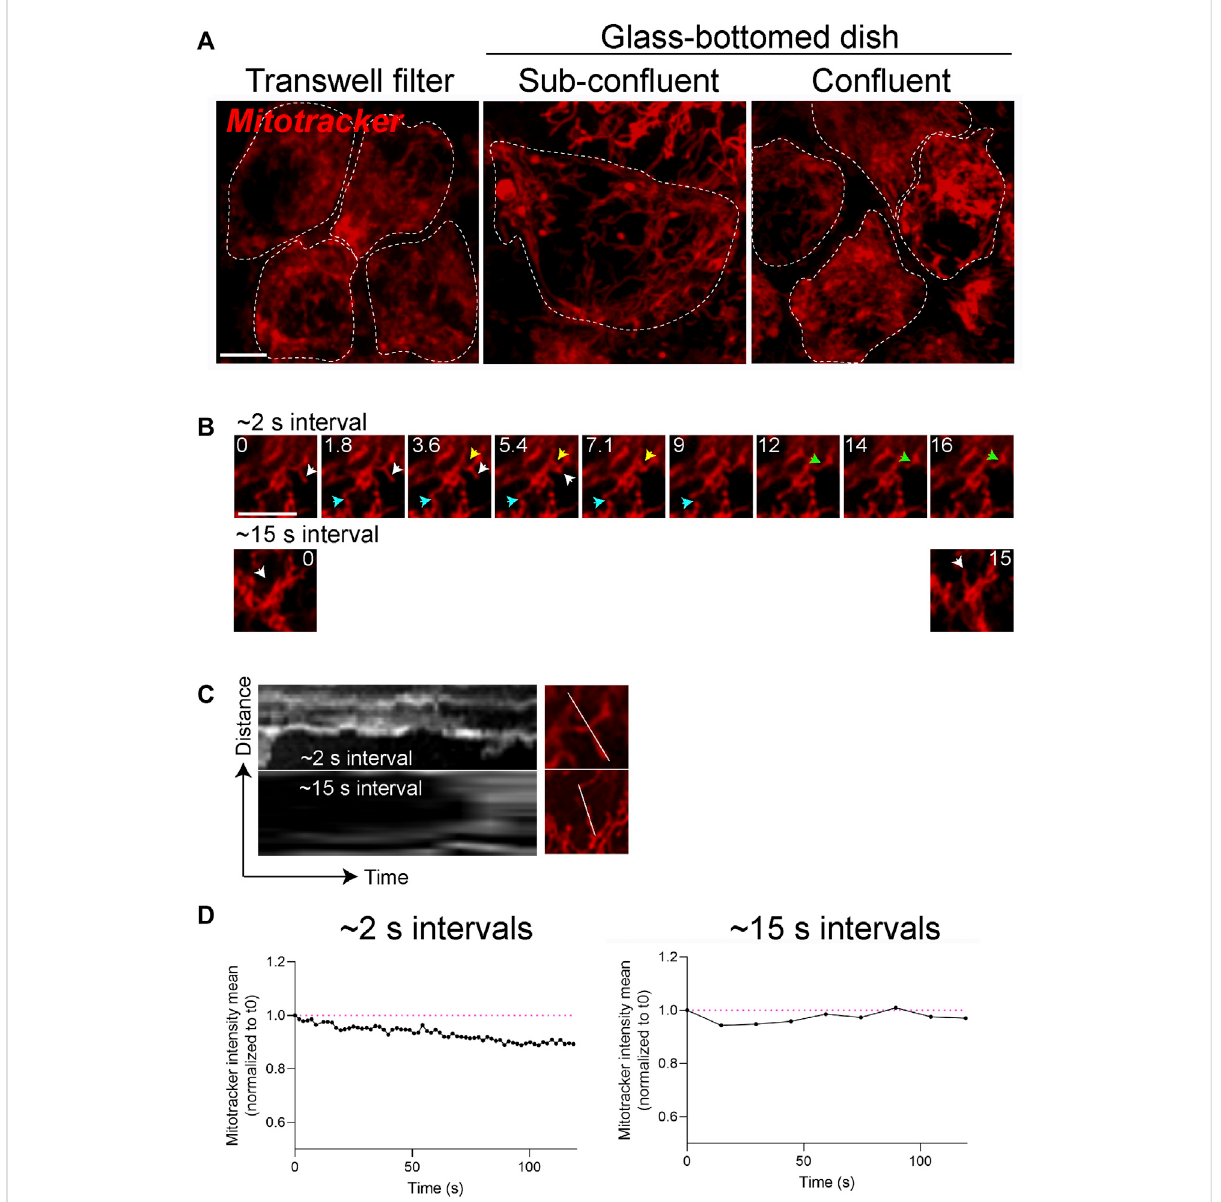
FIGURE 2 Mitochondrial integrity is coupled to RPE polarity and differentiation status. (A) Stills from live imaging of mitochondrial networks (Mitotracker, red) in primary RPE grown on Transwell fi lters to enable differentiation and establishment of polarity or on glass-bottomed dishes. Cell boundaries demarcated by white dotted lines show packing density or con fl uence of the monolayer. Scale bar = 5 µM. (B) High magni fi cation stills from live imaging of mitochondria acquired with ~2 s intervals (top panel) or at 15 s intervals (bottom panel). Only the fi rst ~16 s are shown. Blue, yellow, and white arrows depict distinct fusion or fi ssion events. Scale bar = 5 µM. (C) Kymographs of mitochondrial movements along the indicated axis. Also see Supplementary Movies S1, S2. (D) Photobleaching and loss of signal intensity as a function of acquisition speeds. Magenta lines mark signal intensities at the start of imaging (t =